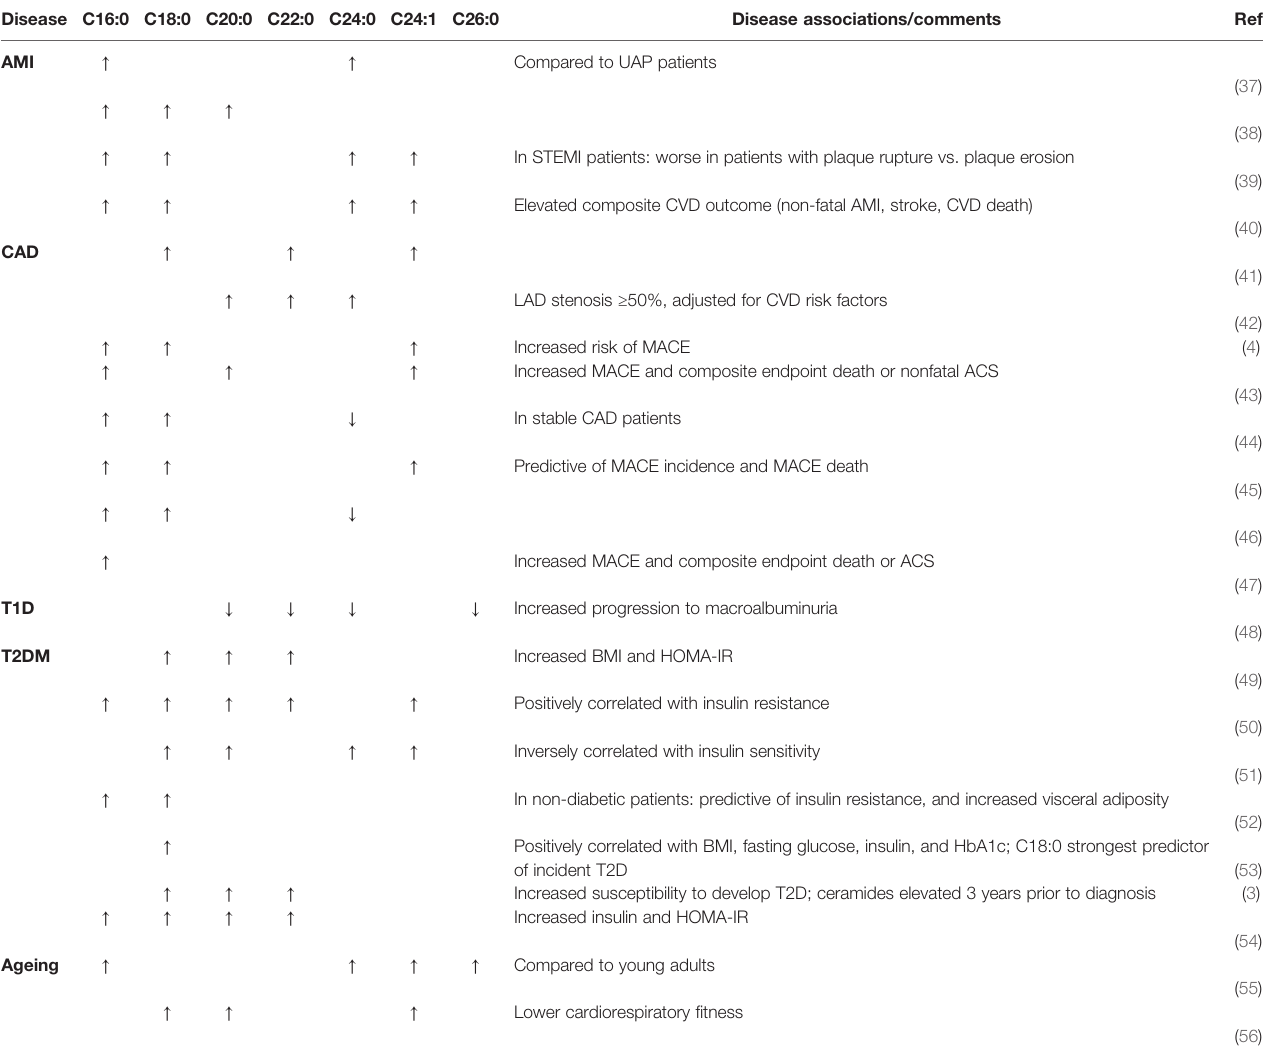
TABLE 1 | Individual circulating ceramide